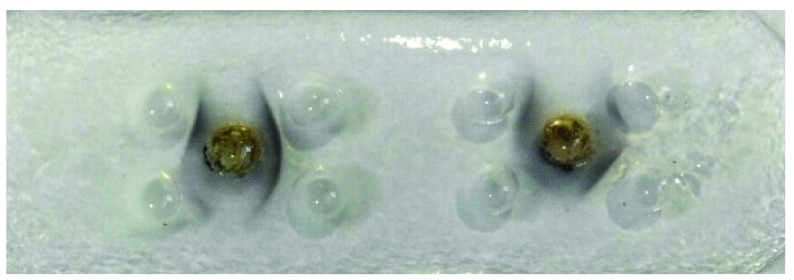
Agarose gel precipitation test of pyocyanin (PCN)-IgY antibody complex batch I and II.The presence of PCN-IgY antibody was detected through the presence of precipitates formed on agarose gel.